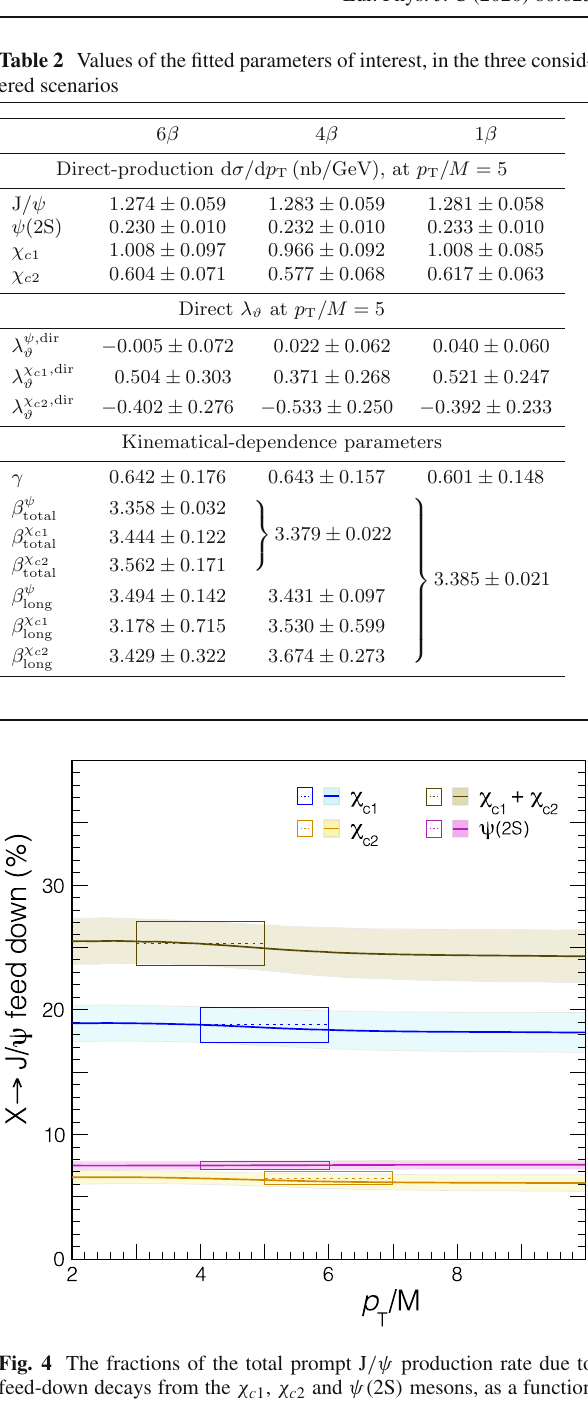
in the figure, as dashed lines (central values) surrounded by empty rectangles (uncertainties); the corresponding numeri- cal values are collected in Table 3. The corresponding results for the polarizations ( λ ϑ in the helicity frame) are presented in Fig. 5, in the left panel for the χ c 1 and χ c 2 mesons and in the right panel for the directly-produced J /ψ mesons. The right panel also